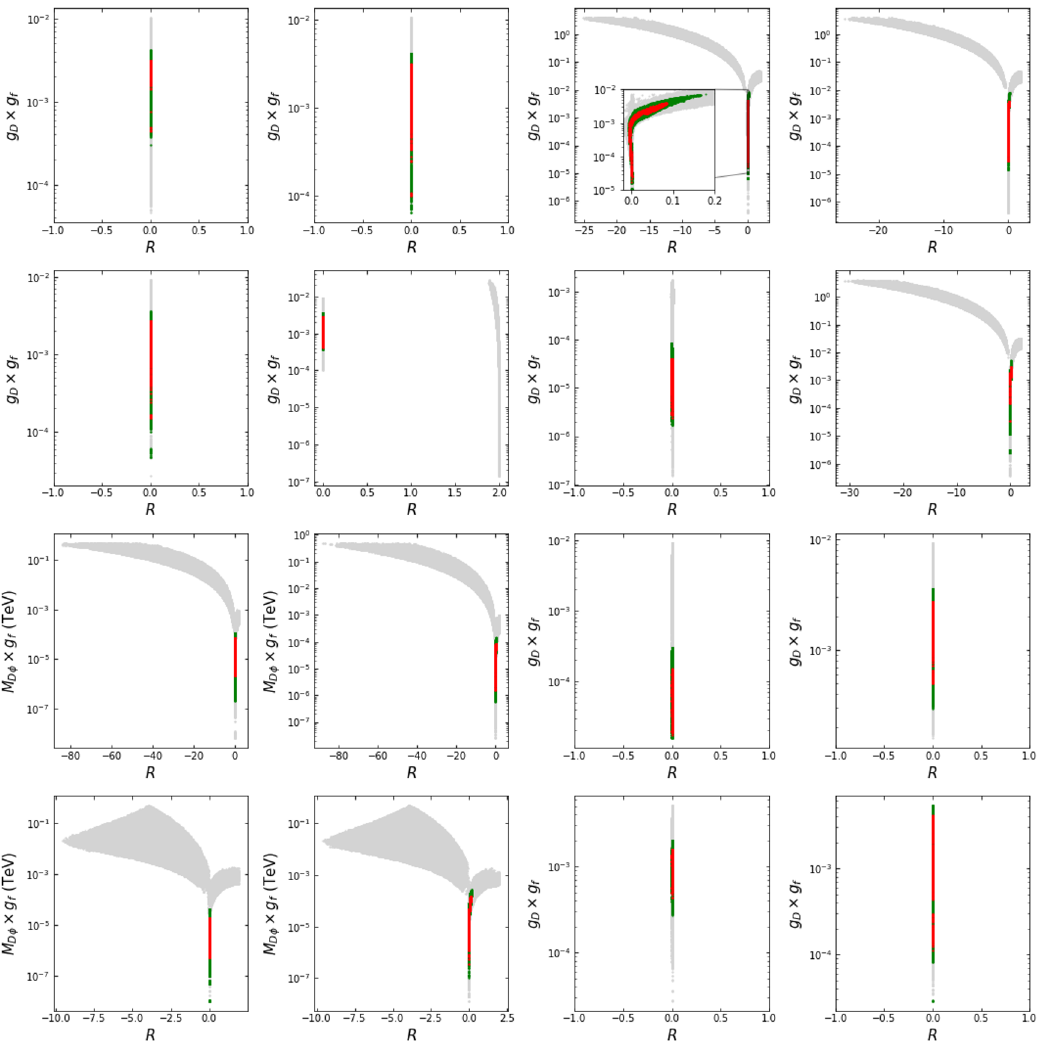
Figure 4 . The 2 σ samples on ( R , M Dφ g f ) plane for L 9 , 10 , 13 , 14 and ( R , g D g f ) plane for else. The resonance parameter is defined as R ≡ (2 m